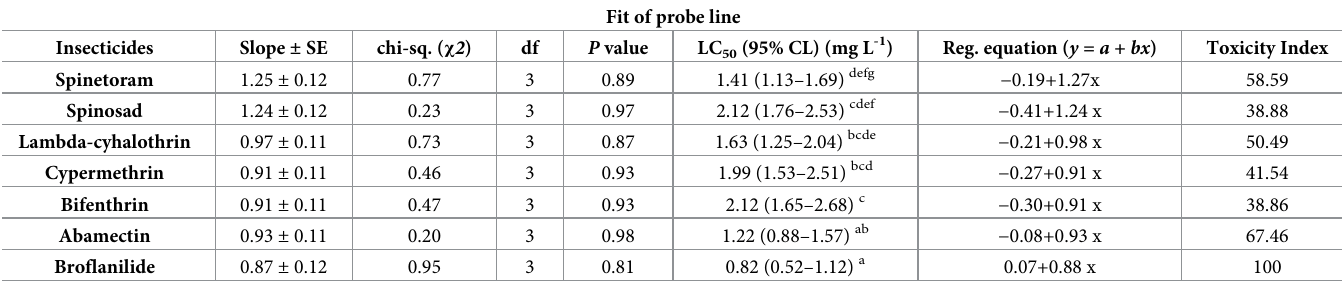
Table 5. Susceptibility of the second instar S . frugiperda larvae to synthetic insecticides at 24 h post-treatment.